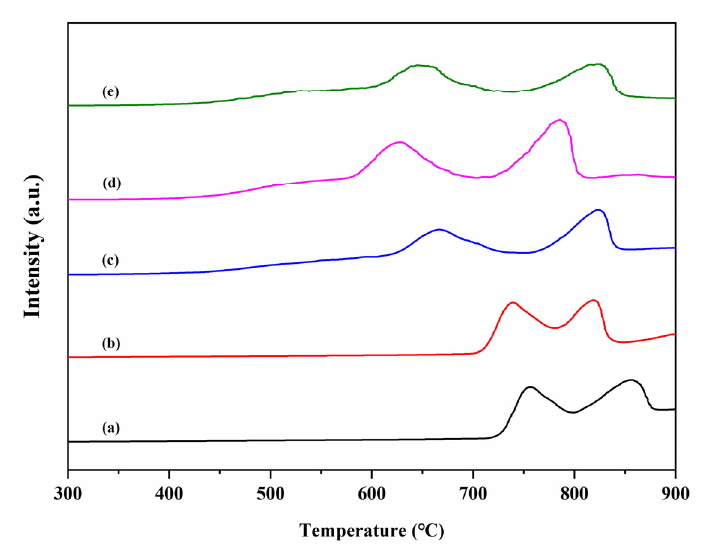
Figure 7. O 2 -TPD profiles of ( a ) OMS-2, ( b ) 1Ni/OMS-2, ( c ) 3Ni/OMS-2, ( d ) 5Ni/OMS-2, and ( e ) 10Ni/OMS-2.